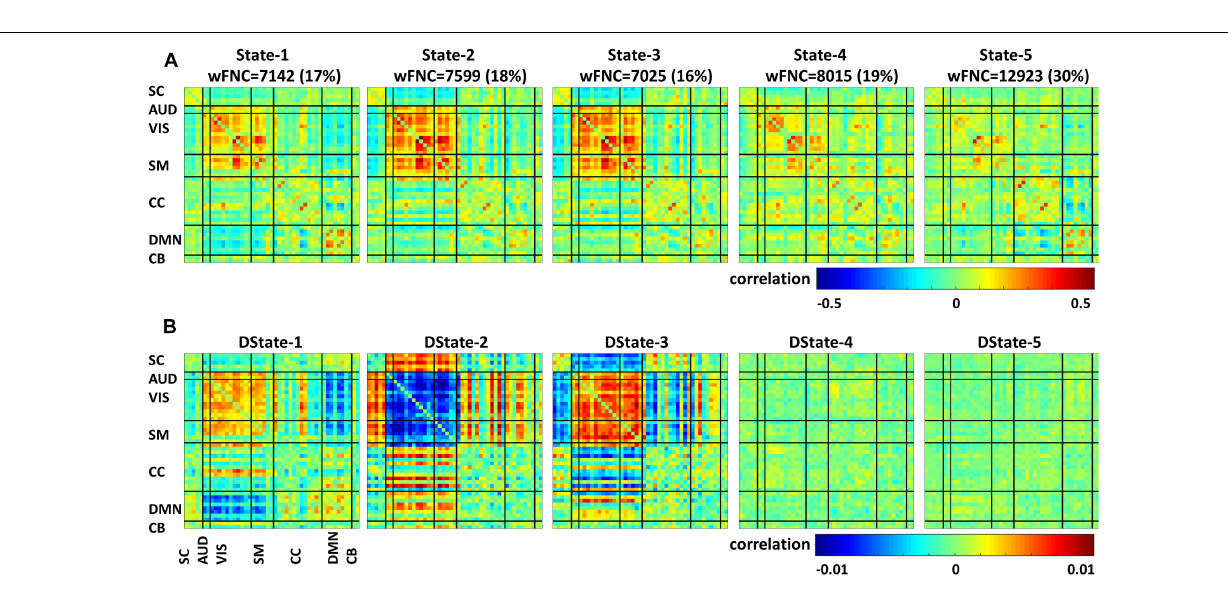
FIGURE 4 | Functional network connectivity states (A) and their derivatives (B)